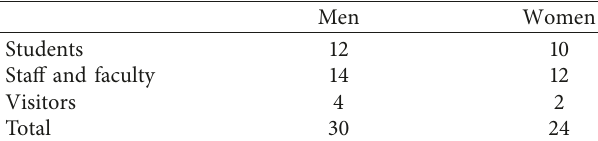
Figure 2: Map of the Male Engineering Building at Qatar University [14]. Table 1: Descriptive statistics of respondents to the